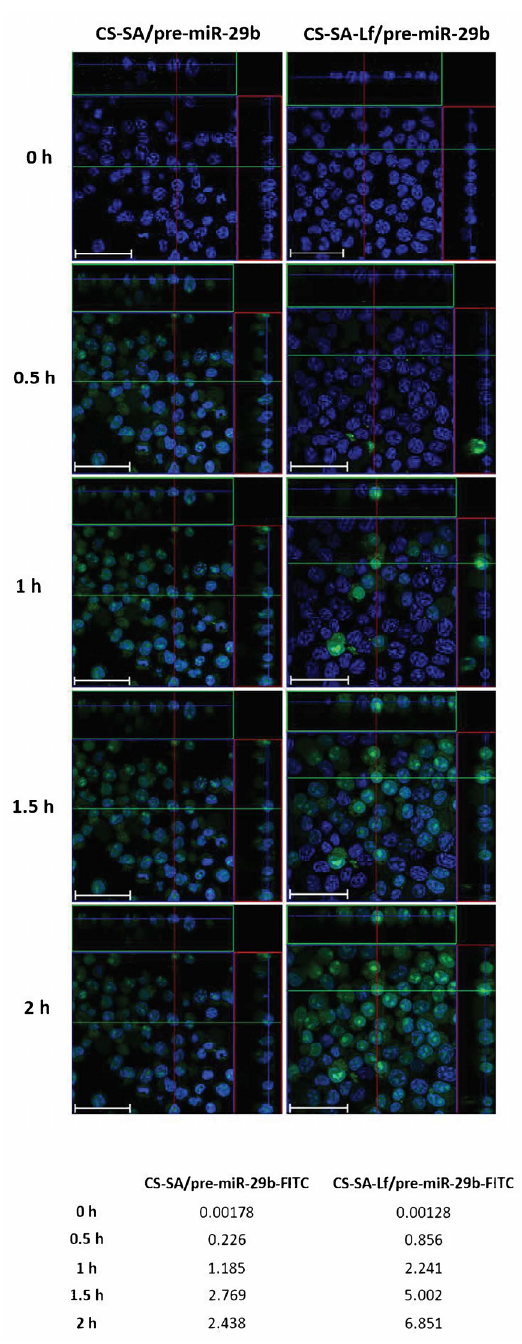
Figure 6. Confocal laser scanning microscopy imaging of N2a695 cells treated with CS-SA / pre-miR-29b-fluorescein isothiocyanate isomer I (FITC) (35 N / P ratio) and CS-SA-Lf / pre-miR-29b-FITC (35 N / P ratio) polyplexes after di ff erent periods of incubation (0.5, 1, 1.5, and 2 h). The fluorescence signals were collected by Laser Scanning Confocal Microscopy (LSCM) with three channels: blue fluorescence from nuclei stained of cells with Hoechst 33342 ® (blue), green fluorescence from FITC labeled pre-miR-29b, and the merged images of three channels. Representative immunostaining data showing most of the FITC-labelled CS-SA-Lf / pre-miR-29b polyplexes localized in the cytoplasm. Scale bars 50 µ m. The values are relative to the average FITC fluorescence